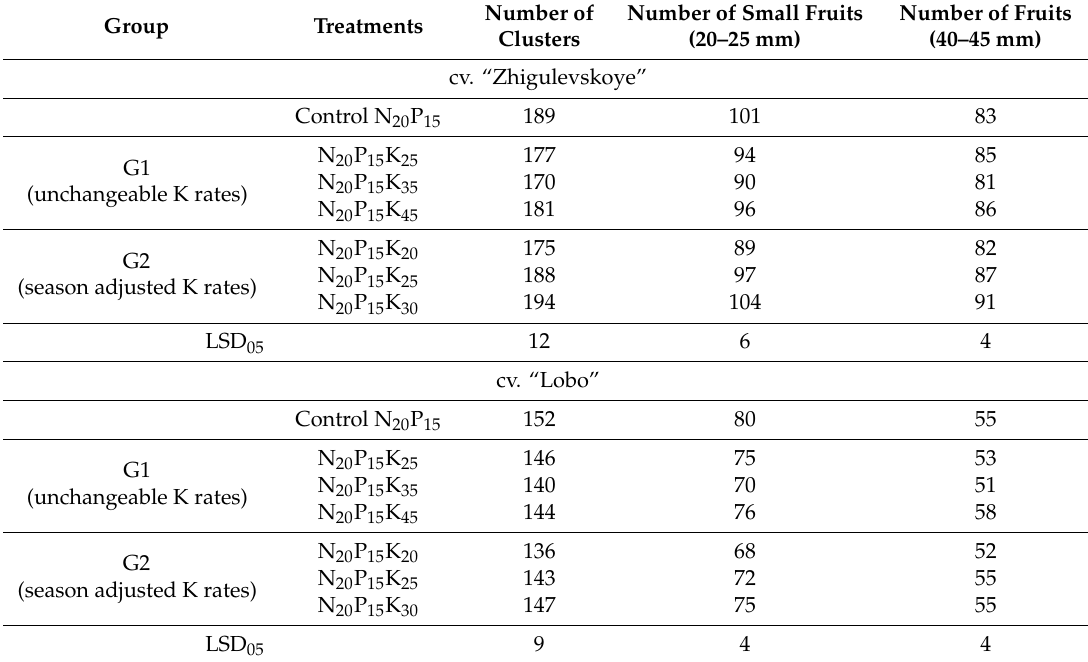
Table 6. Development of productivity components under the e ff ect of various rates of potassium fertilization and fertigation approaches in 2016.